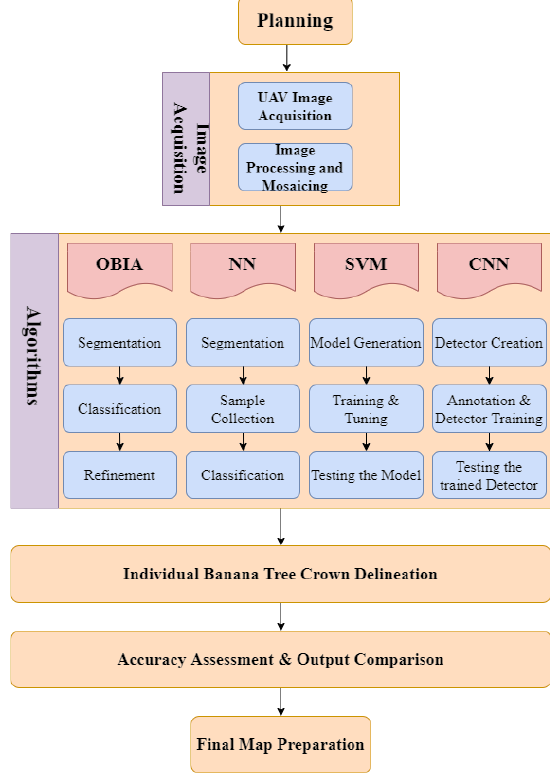
Figure 3. Methodological Flowchart of Banana Tree